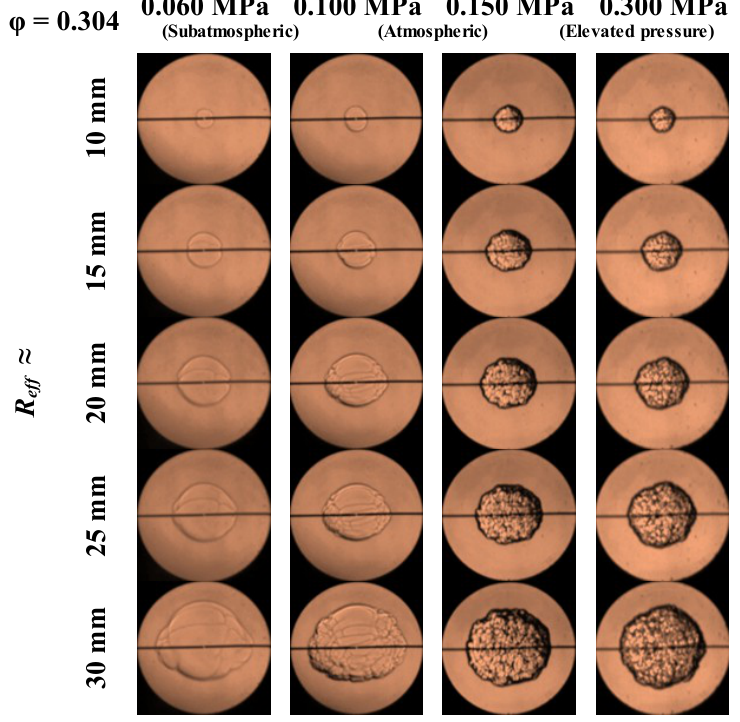
Figure 6. Schlieren images of hydrogen-air premixed flames with φ = 0.304 at different pressures and room